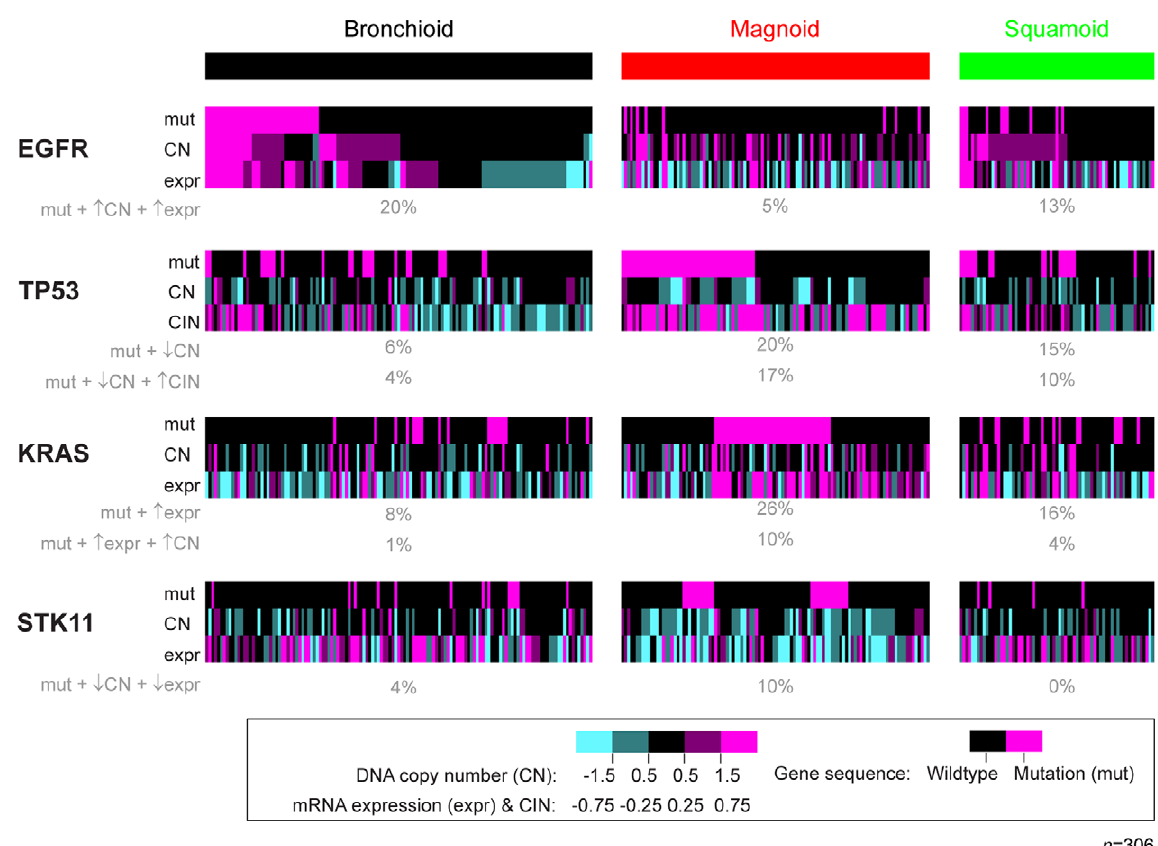
Figure 5. Integrated gene alterations compared among molecular subtypes. Tumors are depicted as columns and genetic features as rows from cohorts with CN and gene sequencing (Chitale et al., Ding et al., UNC). Gene CN’s were defined by the gene’s genomic position. The percentages of tumors within a subtype having a given integrated combination of alterations are displayed in grey. Fisher’s exact tests on each integrated combination and subtype were statistically significant ( P , 0.01).